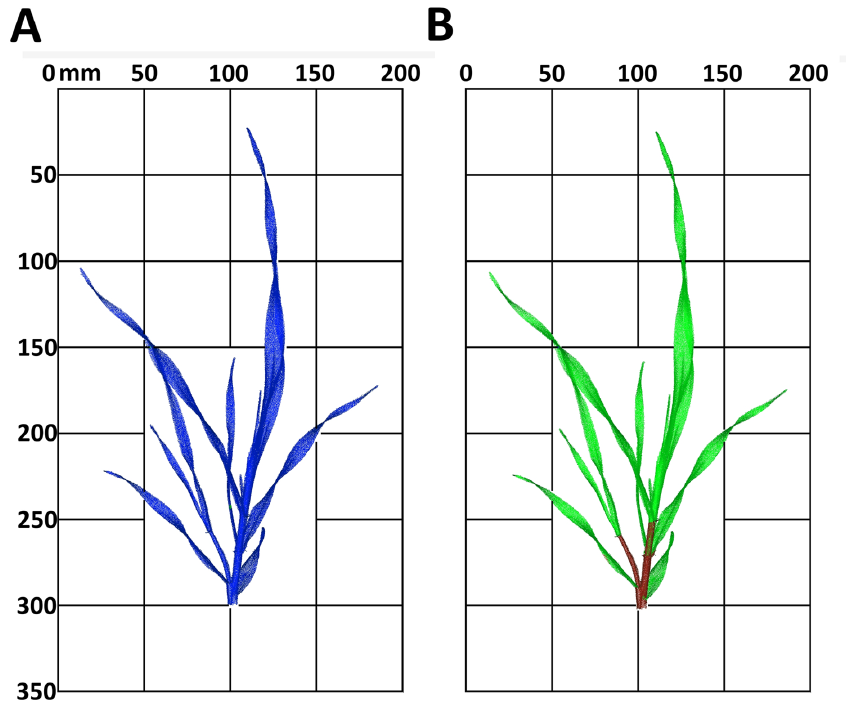
Figure 5. The classification of the raw point cloud ( A ) of the irrigated barley plant from measuring date 17 into the plant organs leaf and stem ( B ) was